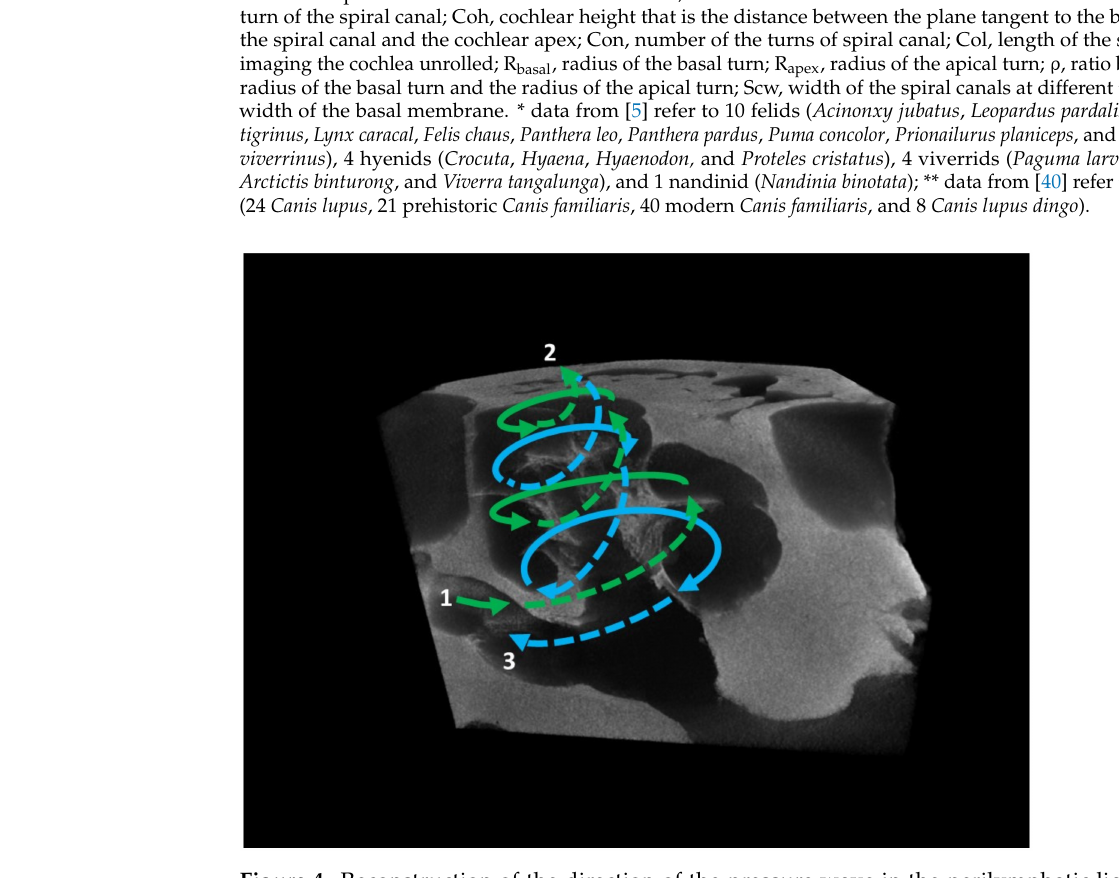
Figure 4. Reconstruction of the direction of the pressure wave in the perilymphatic liquid in the scala vestibuli (green) and in the scala tympani (blue). 1, beginning of the scala vestibuli, near the oval window; 2, helicotrema, point in the apex of the cochlea where both the scalae communicate; 3, beginning of the scala tympani near the round